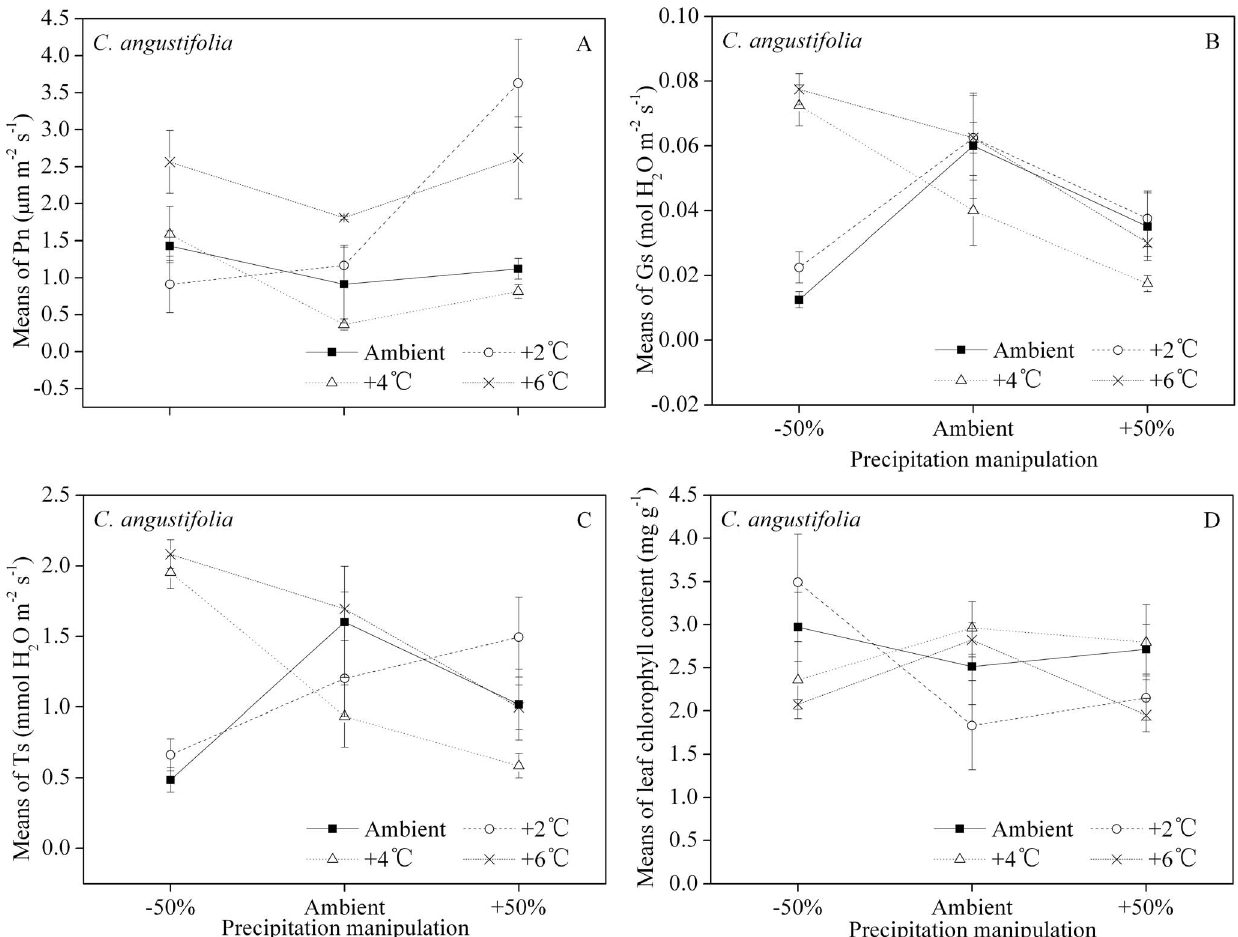
Figure 4. Interactions of temperature and precipitation manipulations on C.angustifolia ’s leaf net photosynthetic rate (Pn, A), leaf stomatal conductance (Gs, B), leaf transpiration rate (Ts, C) and leaf chlorophyll content (D), respectively. The error bars represent means 6 1 standard error.